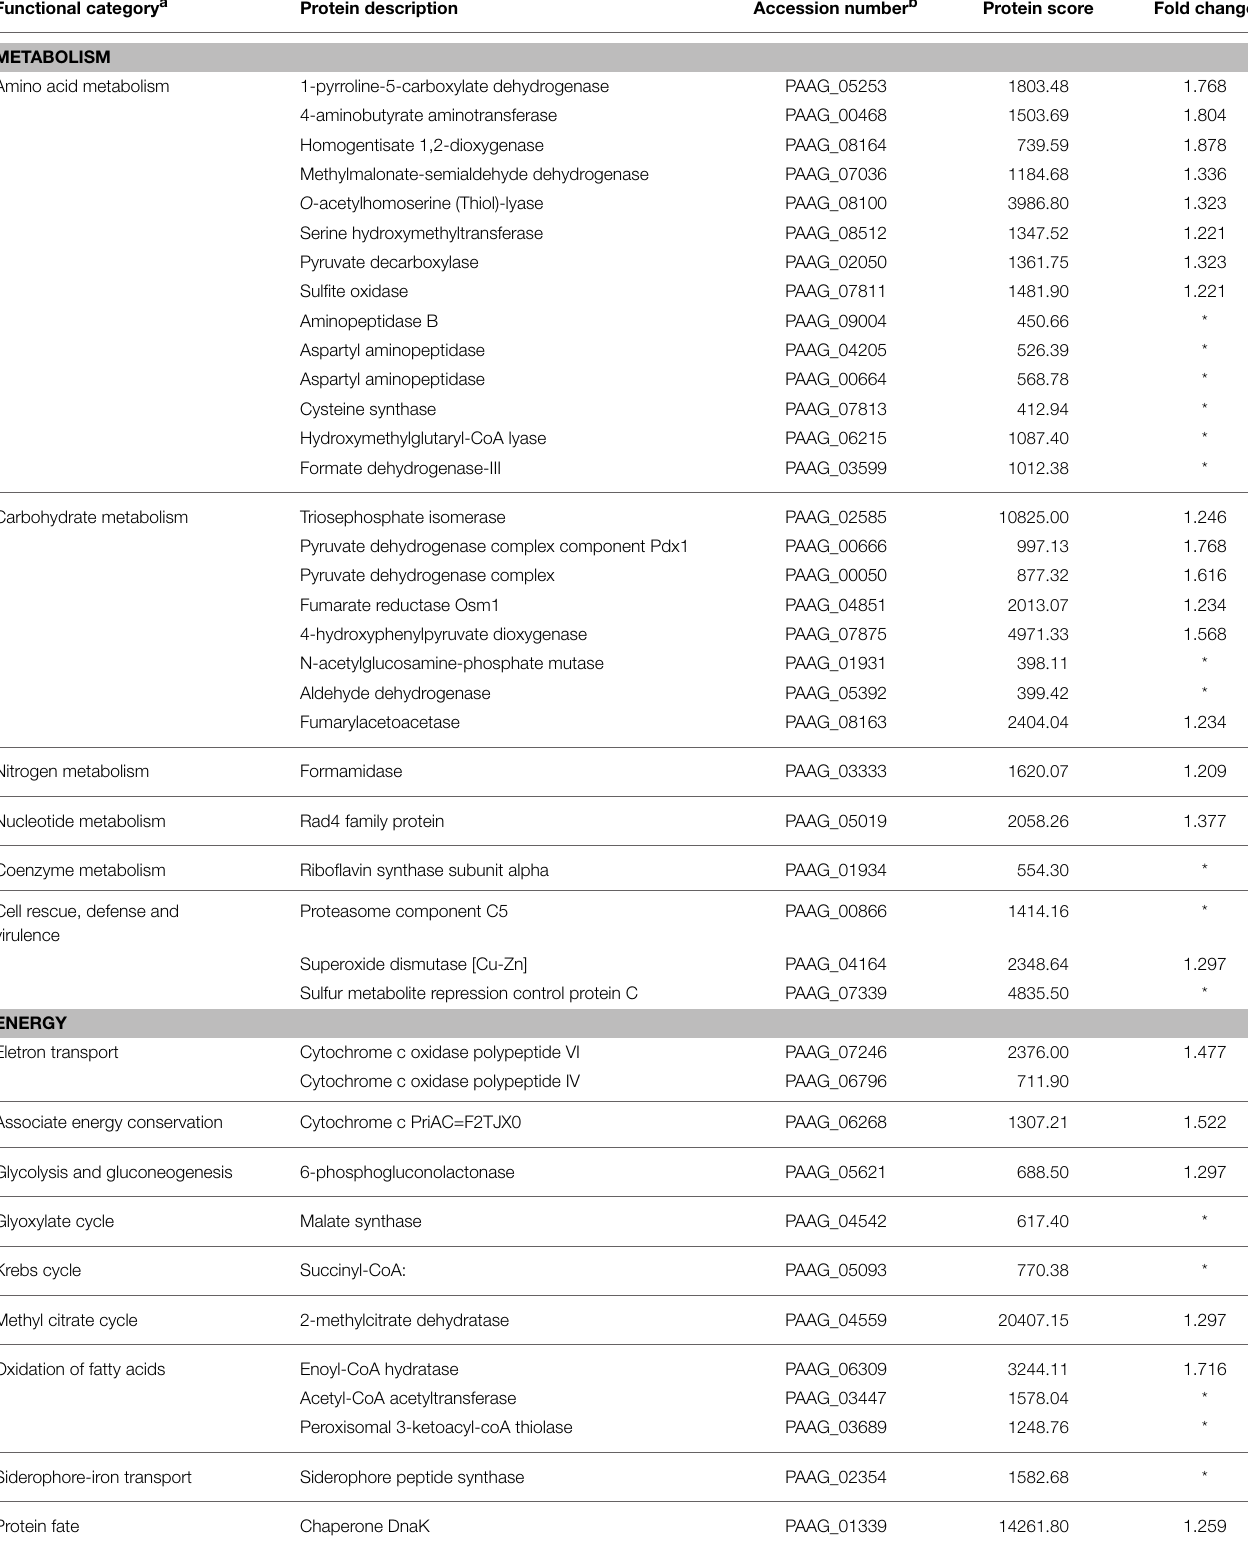
TABLE 1 | P. lutzii more abundant proteins after incubation with argentilactone. Functional category